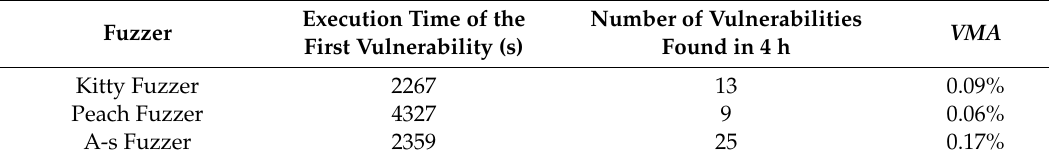
Table 5. Comparison of the experimental results of the three fuzzers. VMA , vulnerability mining